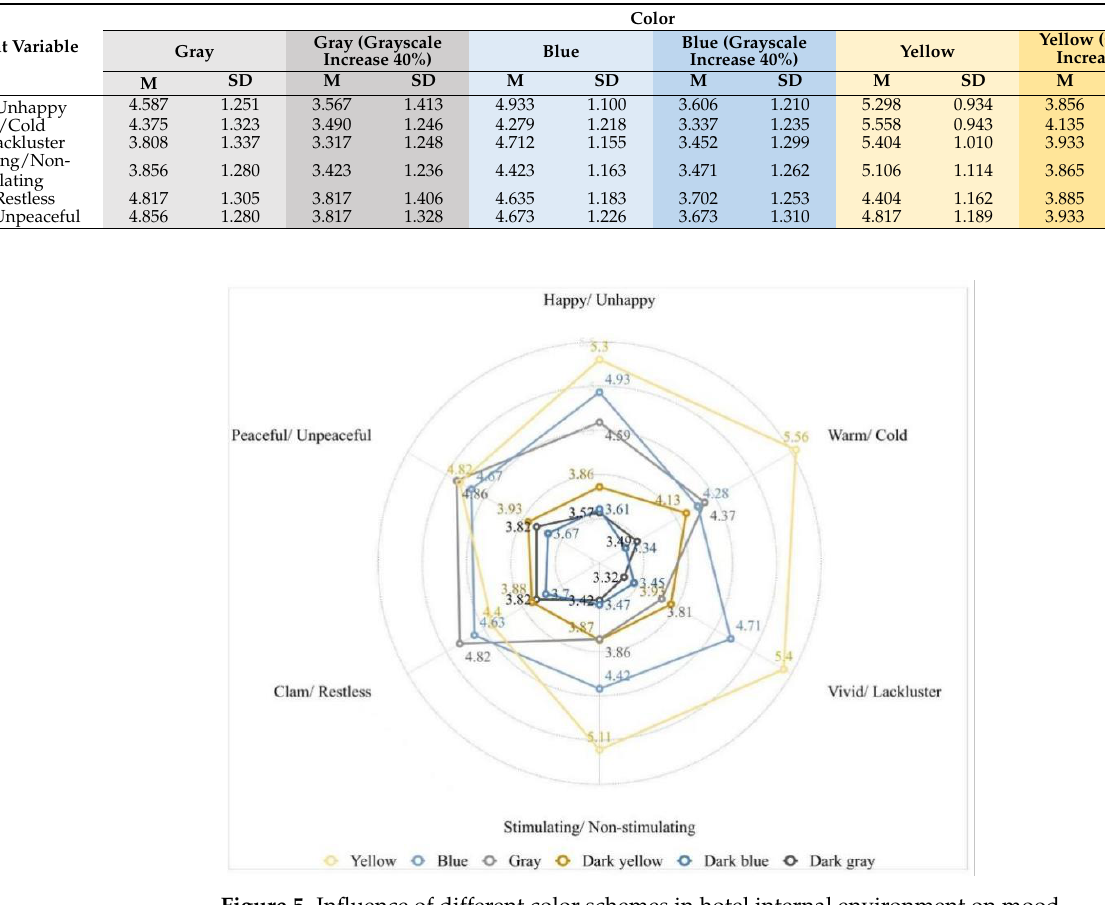
Figure 5. Influence of different color schemes in hotel internal environment on mood. Table 5. Mauchly’s test of sphericity a .